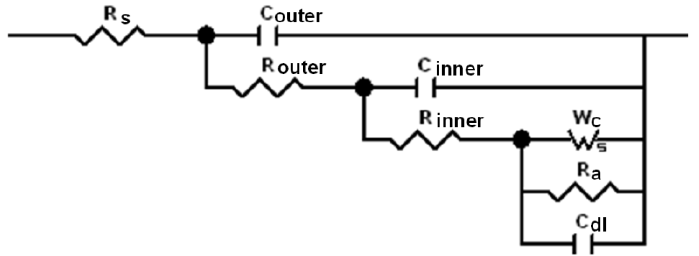
Figure 5. Equivalent circuit for mild steel in artificial seawater under cathodic protection, where R s —resistance of the electrolyte; C outer —capacitor associated with calcium containing layer; R outer —resistance associated with ionic conduction through the occasional pores; C inner —capacitor associated with magnesium containing layer; R inner —resistance associated with ionic conduction through this layer; C dl —capacitor of double layer on metal/deposit interface; R a —anodic charge transfer resistance; W c —cathodic finite-length Warburg